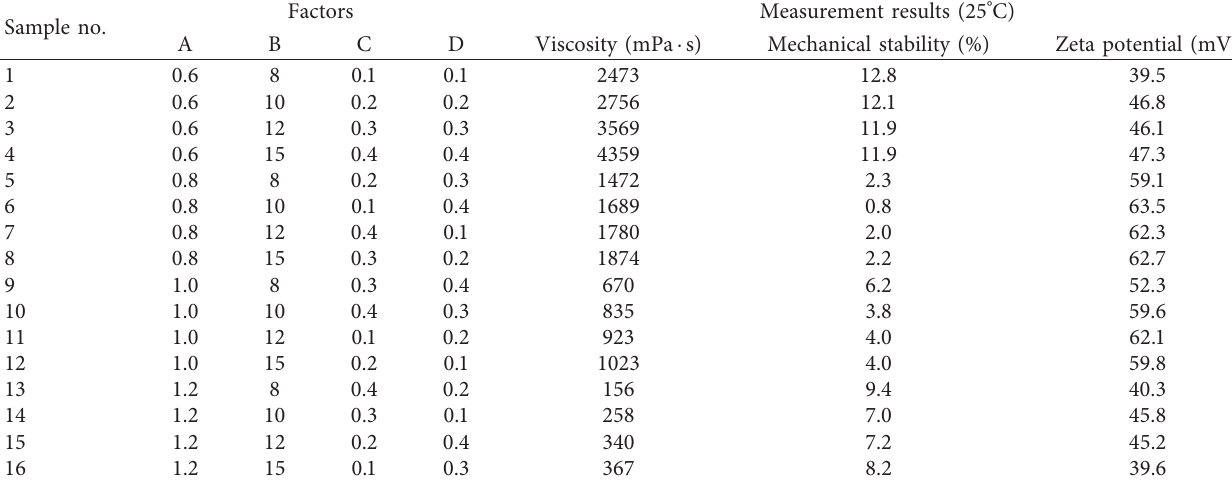
Table 3: Parameters and result of the orthogonal experiments for SBS